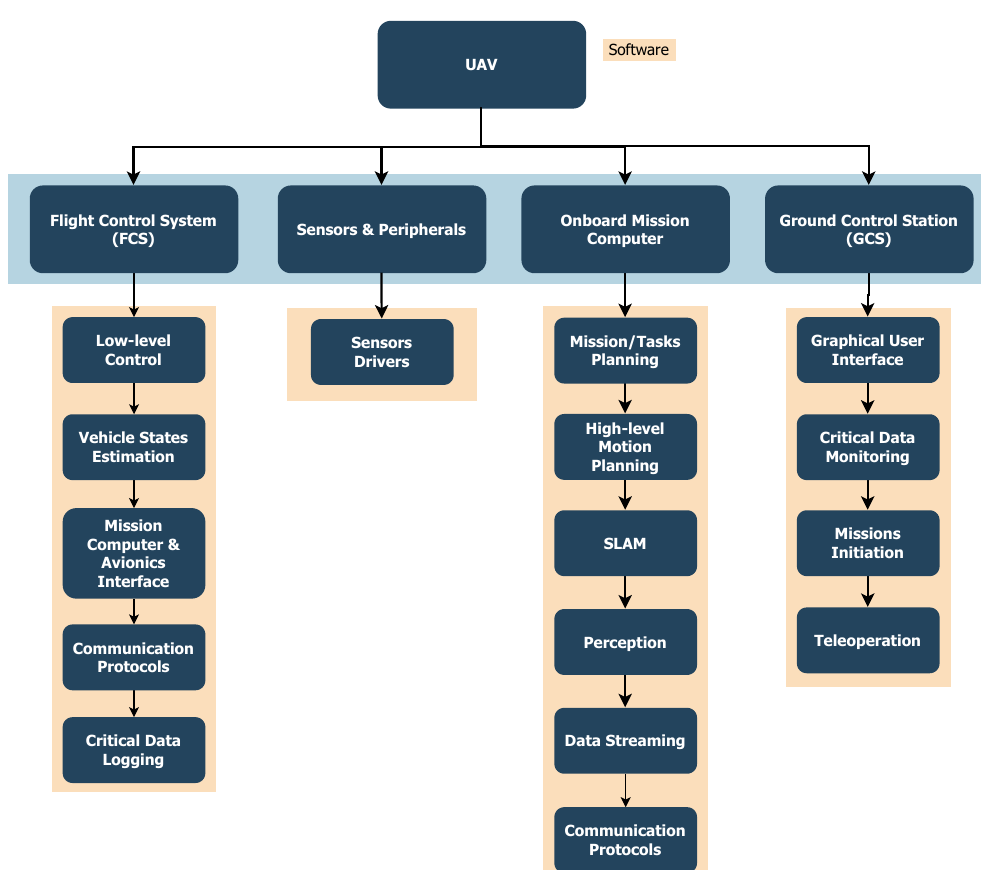
Figure 3. System architecture showing software components commonly used with UAVs.